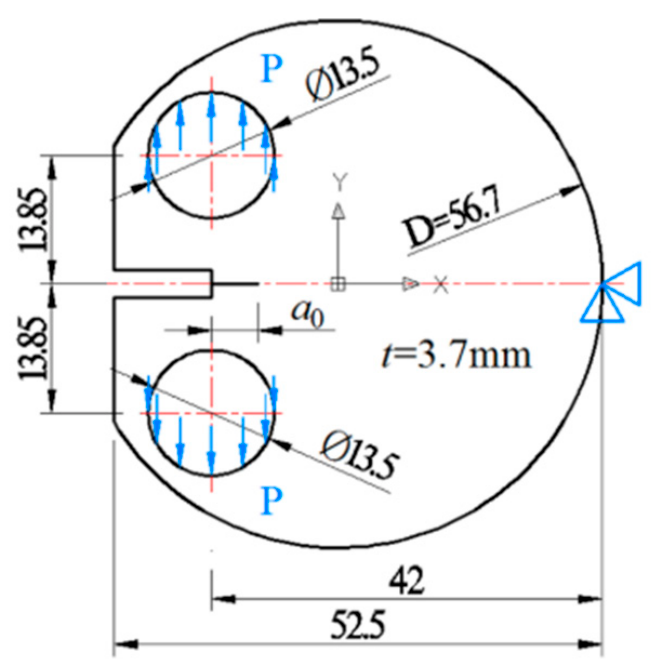
Figure 5. The round compact tension specimen (unit: mm). Table 3. Material properties of 2024-T4 aluminum